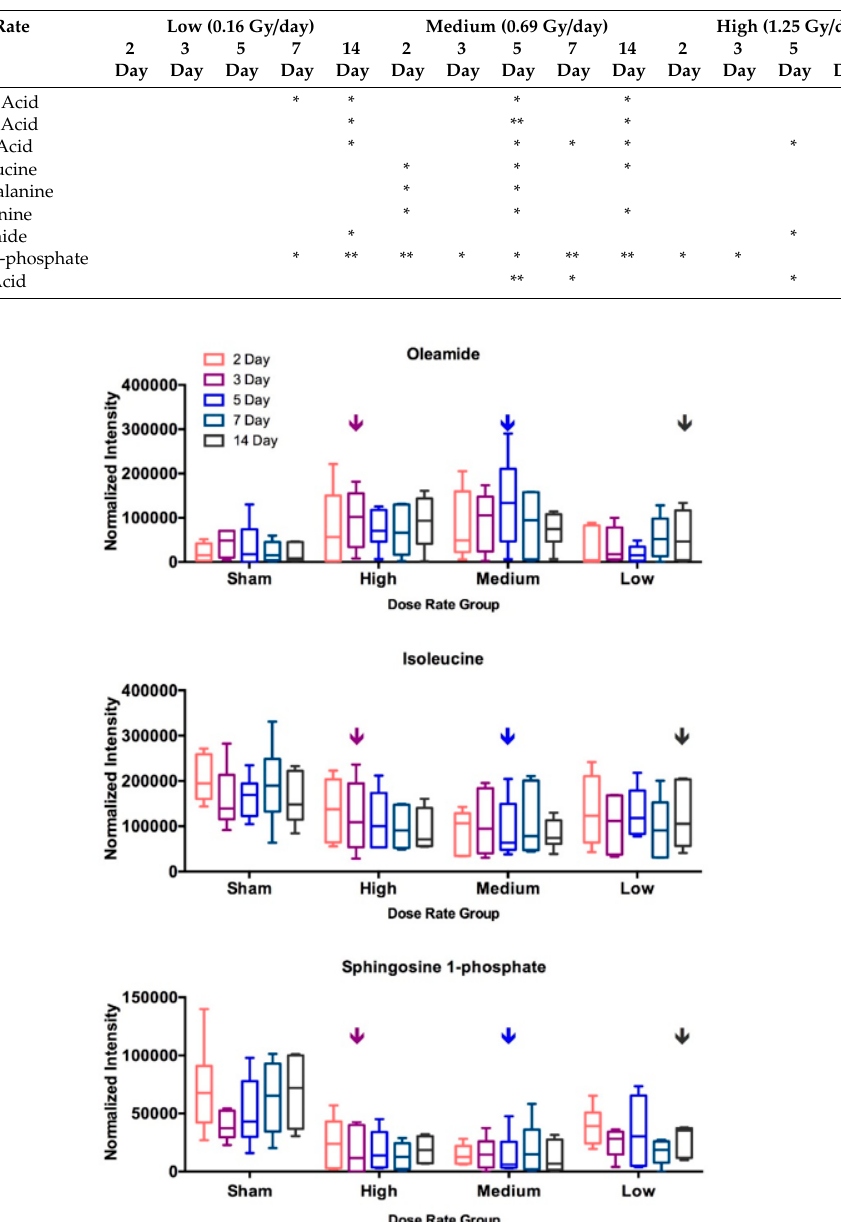
Figure 4. Various dose-rate effects are seen for different metabolites. The time-point pointed by the arrow in each dose-rate group indicates the time-point that achieved 4 Gy. The statistical significance of each post 137 Cs exposure data point compared to its corresponding sham control are shown in Table 2.